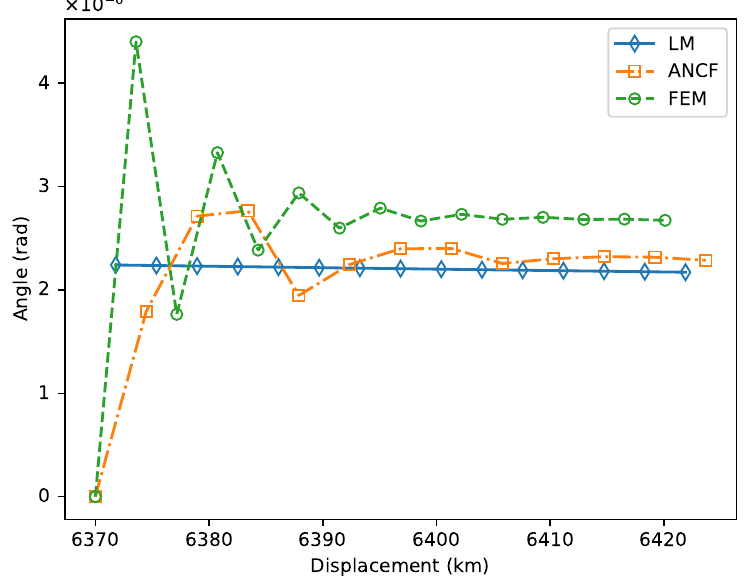
Figure 13. Nodal angle ϕ close to the